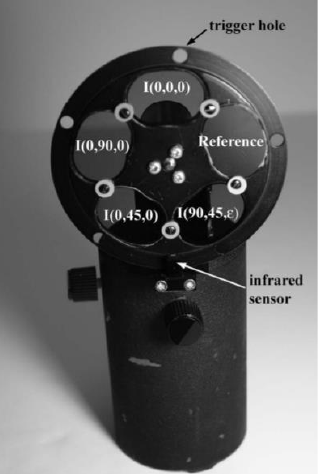
Figure 3. High-speed non-simultaneous polarization imaging system [16].